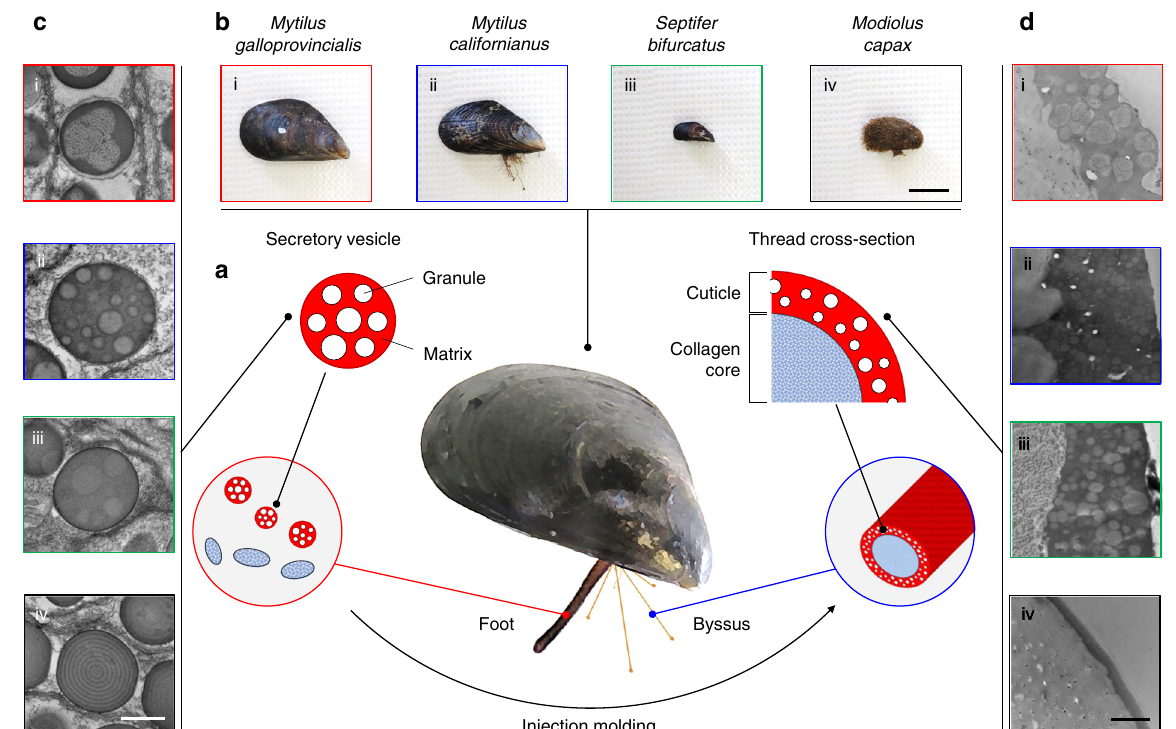
Fig. 1 Fabrication, structural diversity and individual components of the mussel cuticle. All panels labeled with (i) represent M. galloprovincialis , (ii) M. californianus , (iii) S. bifurcatus , and (iv) M. capax . a Scheme of cuticle processing in the mussel highlighting the prefabrication of individual granules and surrounding matrix within secretory vesicles in the foot and via injection molding, leading fi nally to a coalescence and hardening of myriad secreted vesicles as the byssal cuticle; b Images of the four types of mussels selected for this study, (scale bar = 2 cm). c TEM micrographs of the cuticle precursors (scale bar = 0.5 µ m); d TEM micrographs of lateral cross-sections of mussel threads (scale bar = 1 µ